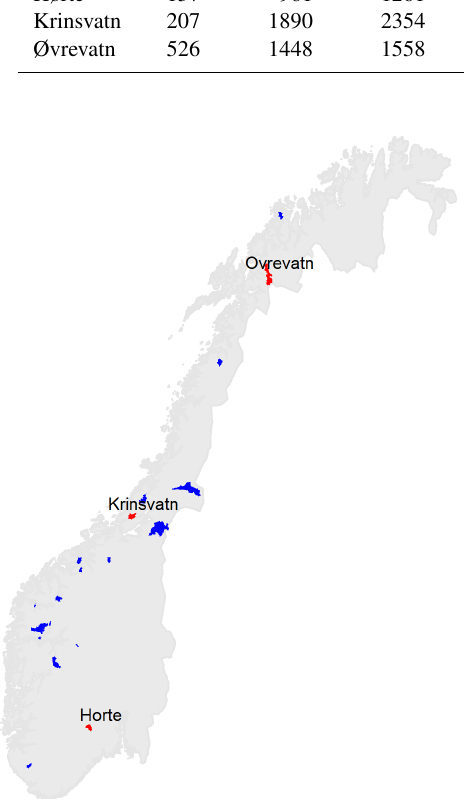
Figure 2. Location of the selected catchments. The catchments Hørte, Øvrevatn and Krinsvatn, for which we show the method in more detail, are plotted in